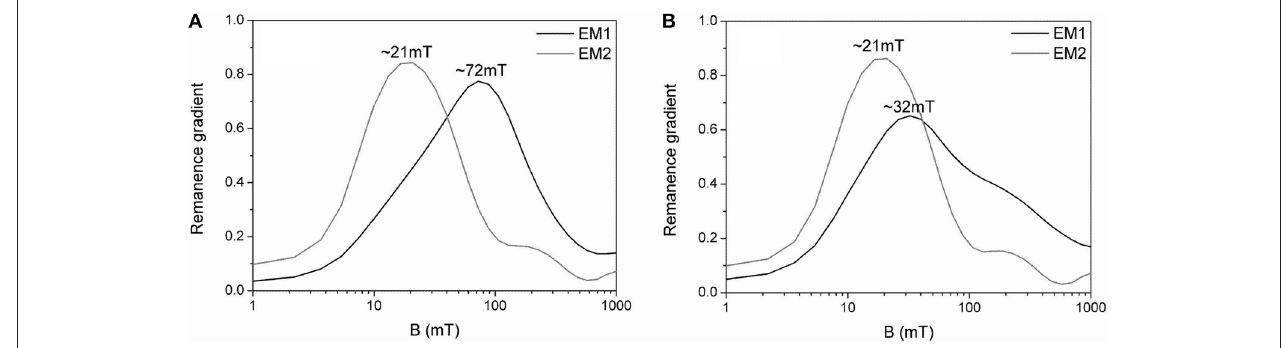
FIGURE 10 | A comparison end members (EMs) of backfield IRM curve unmixing of the Chaona (A) loess-paleosol and (B) red-clay samples. Modified from Nie et al.